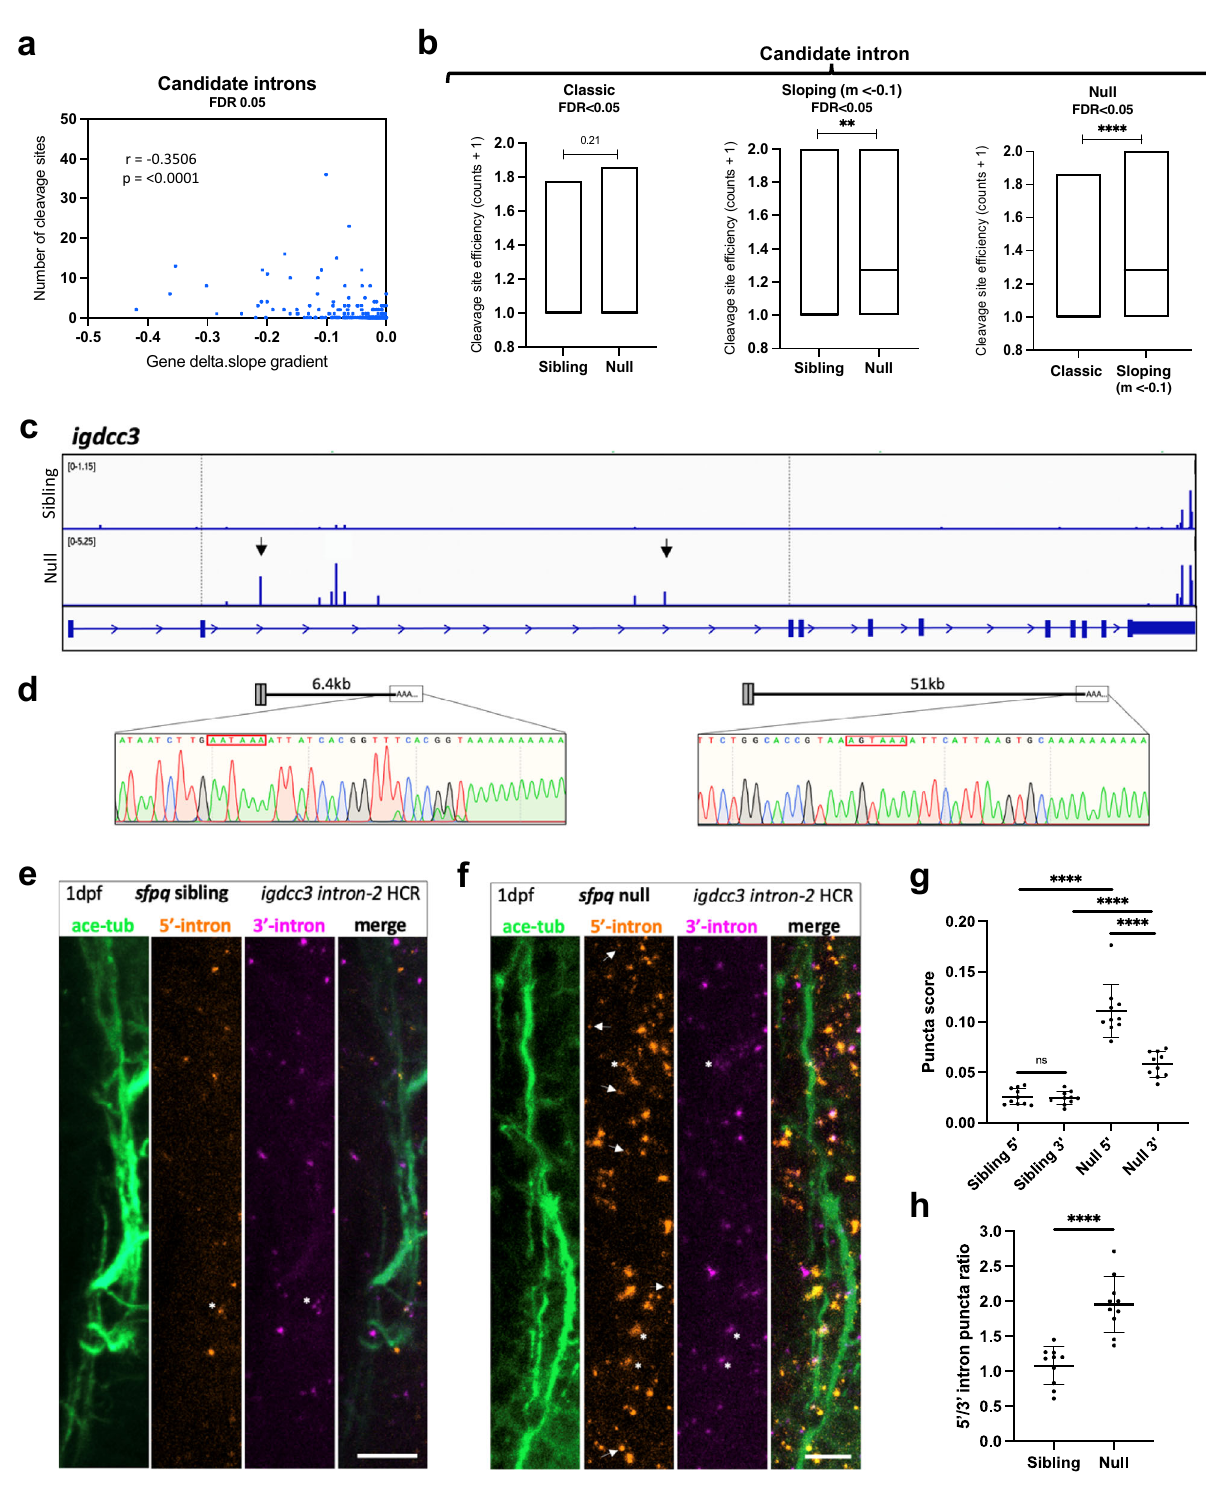
While intron retention and SFPQ misregulation are hallmarks of control counterparts.Of these, 21 genes were overlapping in2 or more ALS/FTLD,todate,transcriptopathyandintronicpolyadenylationhave oftheALSdatasets,with EXT1 showingsigni fi cantslopingin4datasets, not been associated with neurodegenerative disease. To explore and TOX, FAM110B, SSBP2 and CRHR1 each sloping in 3 datasets whether the PreT-IR phenotype uncovered in zebra fi sh neurites is also (Supplementary Table 2). Mouse homologues of 20 out of 21 of the a hallmark of ALS, we analysed six total RNAseq datasets from ALS genes were SFPQ binding, with most (17/21) exhibiting very strong patients,mousetissuesandcellularmodels 33,36 – 40 .Thesedatasetsshow binding (Supplementary Fig. 11). Impressively, homologues for 13 of variety in the genetic basis of ALS, representing sporadic and FUS the 21 genes show neurite-enriched PreT-IR in zebra fi sh null neurons. The other 8 just miss the statistical cut-off. Transcripts truncated within long retained introns, stabilised, and localised to null